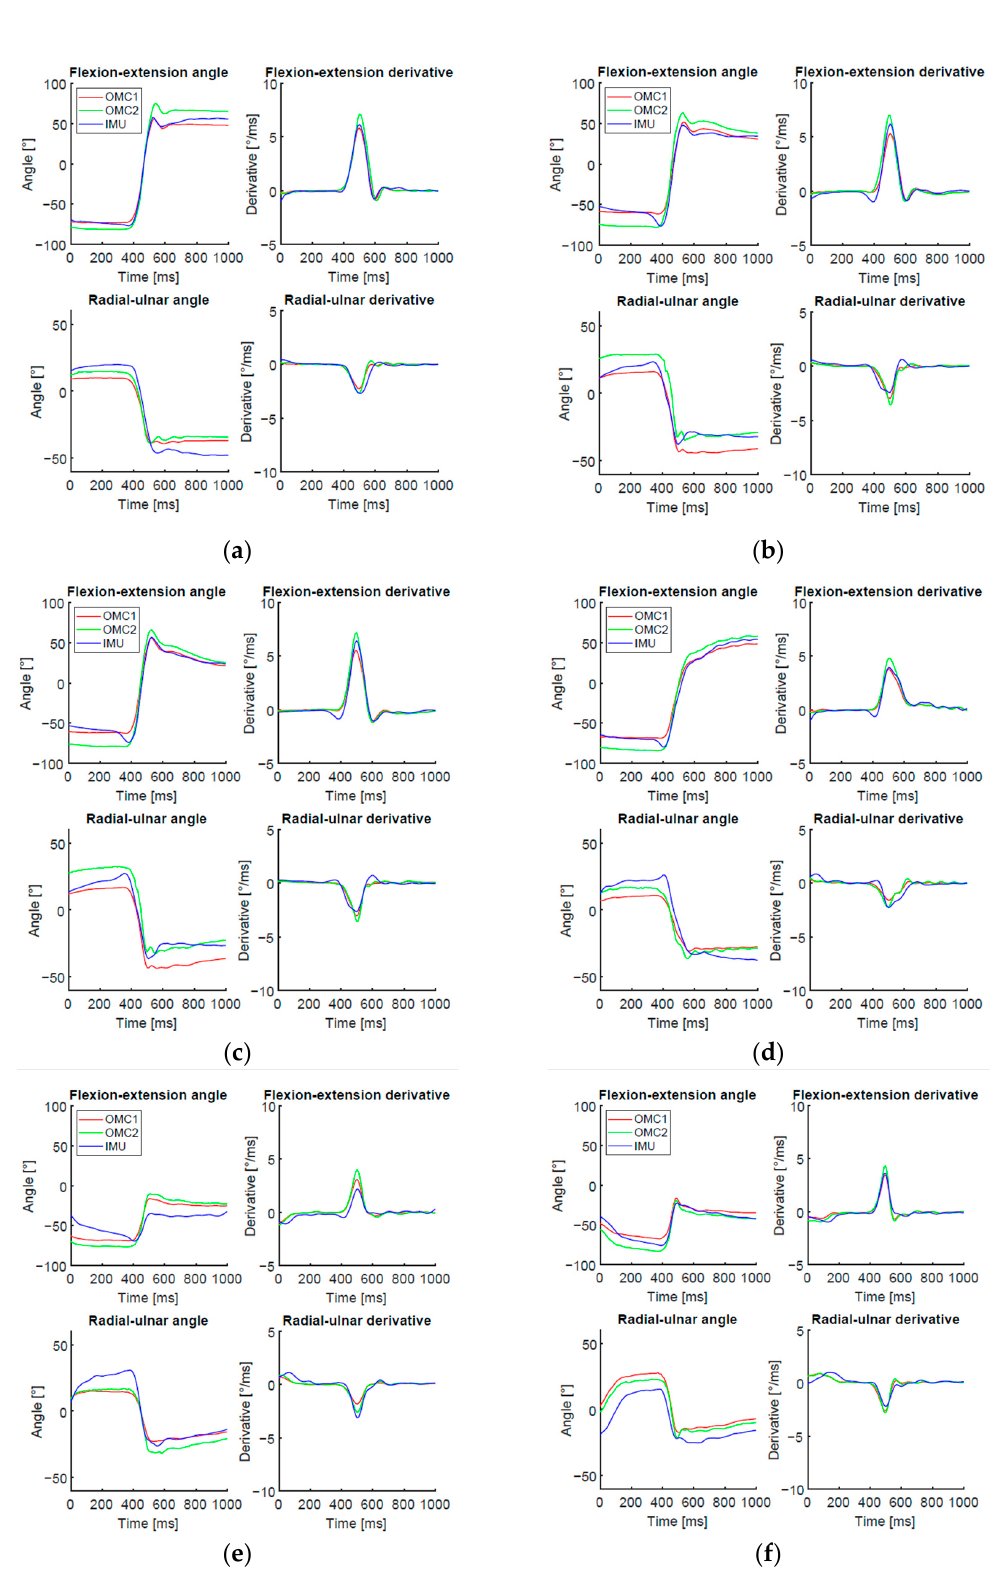
Figure 5. Examples of individual trials representing ( a ) standard case of the DTM, ( b ) additional wrist extension movement at the beginning of the throwing movement in the IMU signal approximately between 35-40ms while both OMC signals remain constant, ( c ) noise of the OMC2 signal, ( d ) flexion angle is maximal at the end of the selected signal, true maximal value is cut off, ( e ) difficulties in temporal alignment because of big differences in the shape of the signals, ( f ) small movement in the wrist without reaching positive joint angles (corresponding to no wrist flexion) while throwing the object.